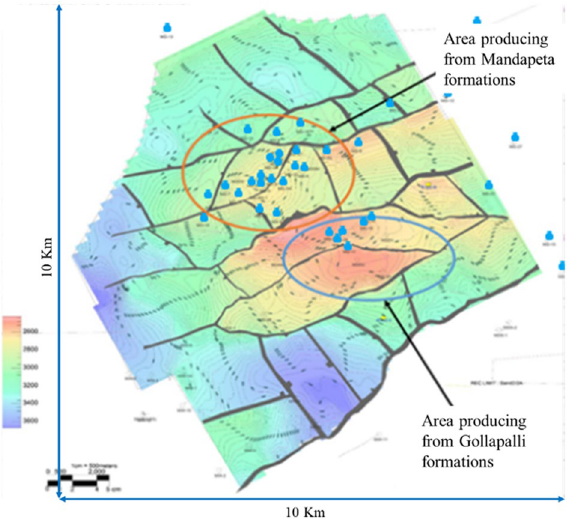
Figure 2. A structural map showing fault traces by black lines and well positions by cyan dots.